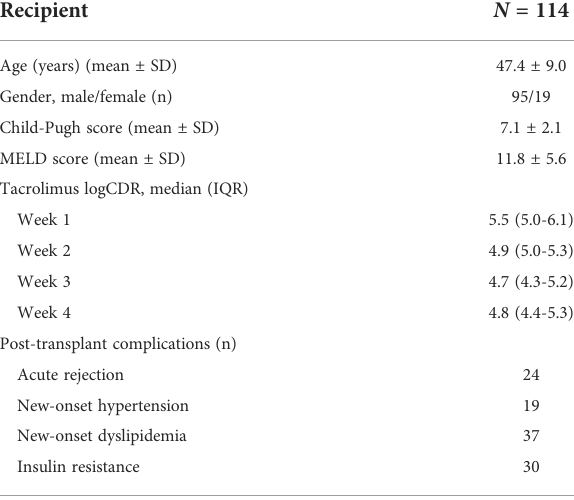
TABLE 1 Characteristics of patients enrolled in this